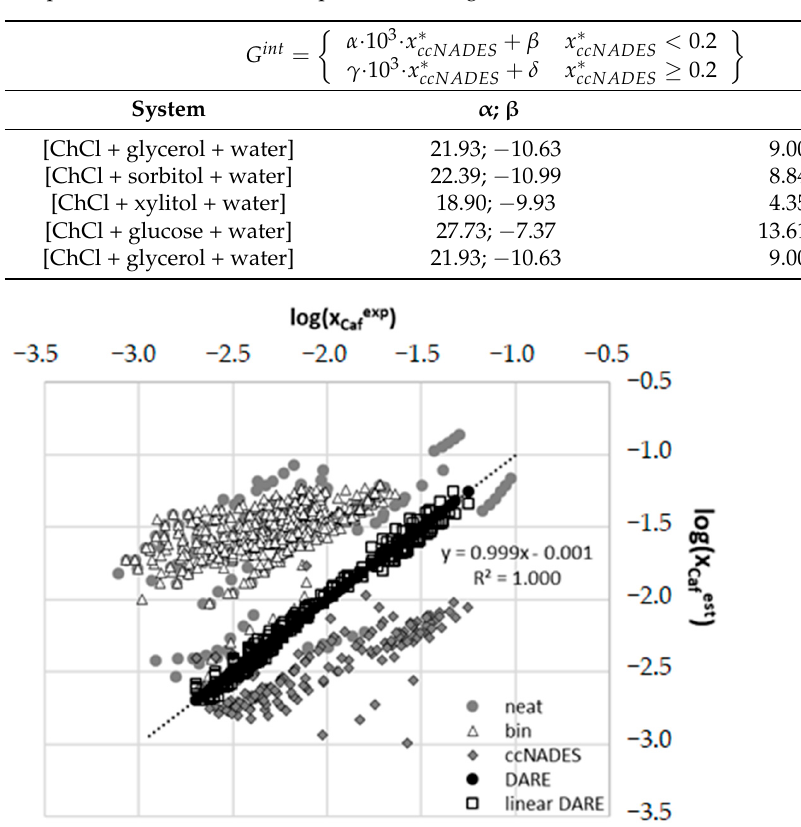
Table 2. The values of parameters defining linear relationship G int as a function of ccNADES composition derived from data presented in Figure 12.